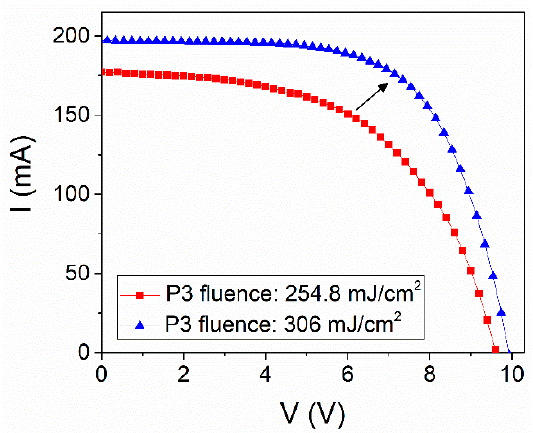
Figure 4. P3 parameter optimization and the relative I-V curves for the as-realized modules. In particular, module realized employing a non-optimized laser fluence (254.8 mJ·cm − 2 ) during P3 (square symbols—red line) demonstrated power conversion efficiency ( PCE ) of 11.23% while module realized employing an optimized laser fluence (306 mJ·cm − 2 ) showed PCE up to 15.29% (triangle symbols—blue line). The reported I-V curves were acquired under 1 SUN illumination. Table 1 . Electrical parameters (extracted from 1 SUN I-V curves) for modules realized by employ- ing non-optimized (first row) and optimized (second row) laser fluence value during P3 ablation step. The optimized removal of gold layer led to an increased module current and PCE , due to full electrical isolation of the module sub-cells from the counter electrode (CE) side.